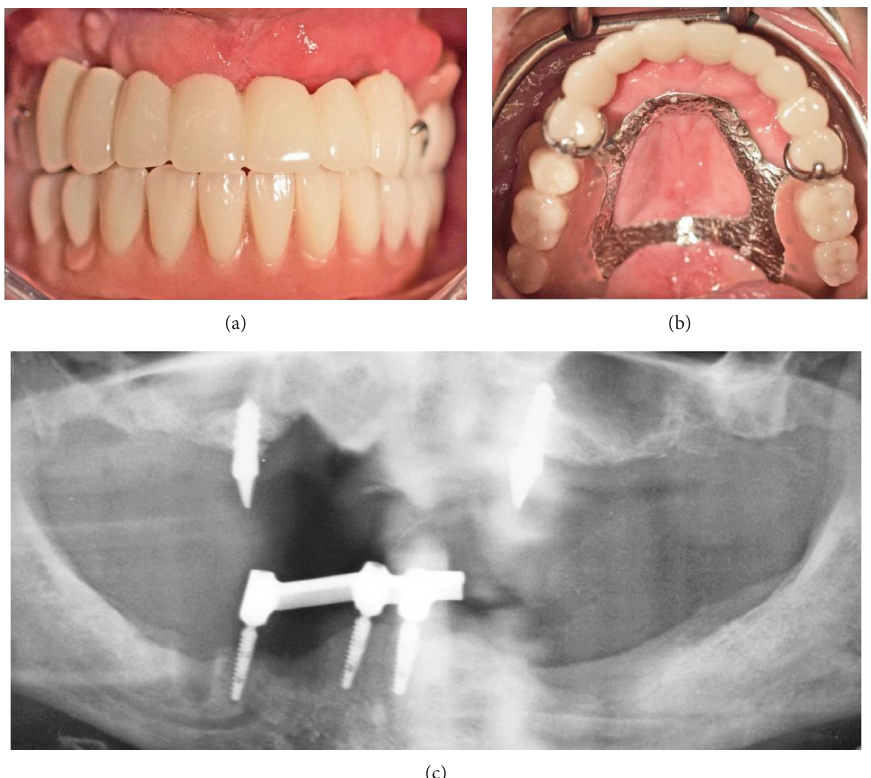
Figure 7: (a, b) Maxillary temporary rehabilitation with FPD retained on implants #4 and #10 and removable denture for the molar areas. (c) OPG 4 weeks after surgery with the mandibular overdenture (not modified radiograph taken during current treatment).